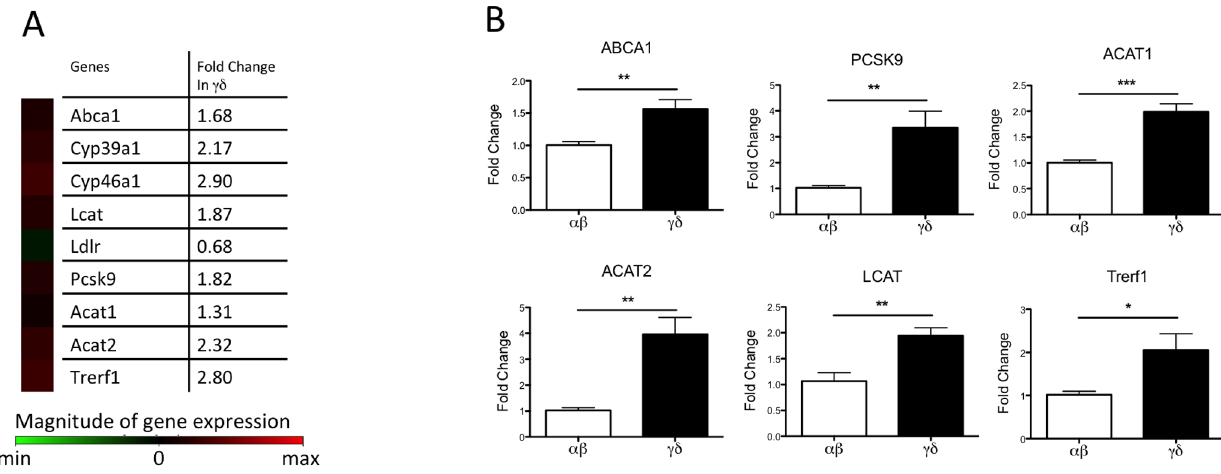
Figure 1. Cholesterol metabolism is differentially regulated in ab and cd T cells. (A) Heat map of sterol PCR array. Genes involved in sterol esterification, utilization, and efflux are upregulated in cd T cells. Gene expression of ab T cells was used as control to calculate fold change and hence not shown in the heat map. ab and cd T cells were isolated from spleens of the same female C57BL/6J mice by immuno-magnetic beads. (B) Quantitative RT-PCR analysis of genes regulating sterol metabolism. mRNA was isolated from ab and cd T cells from the same female C57BL/6J mice, and gene expression was detected by Taqman-based assays. Gapdh was used to normalize gene expression, and gene expression in ab T cells were set as 1. N=6. One sample was pooled from 3 mouse spleens. Results were shown in mean 6 SEM. * P , 0.05, ** P , 0.01, *** P , 0.001.